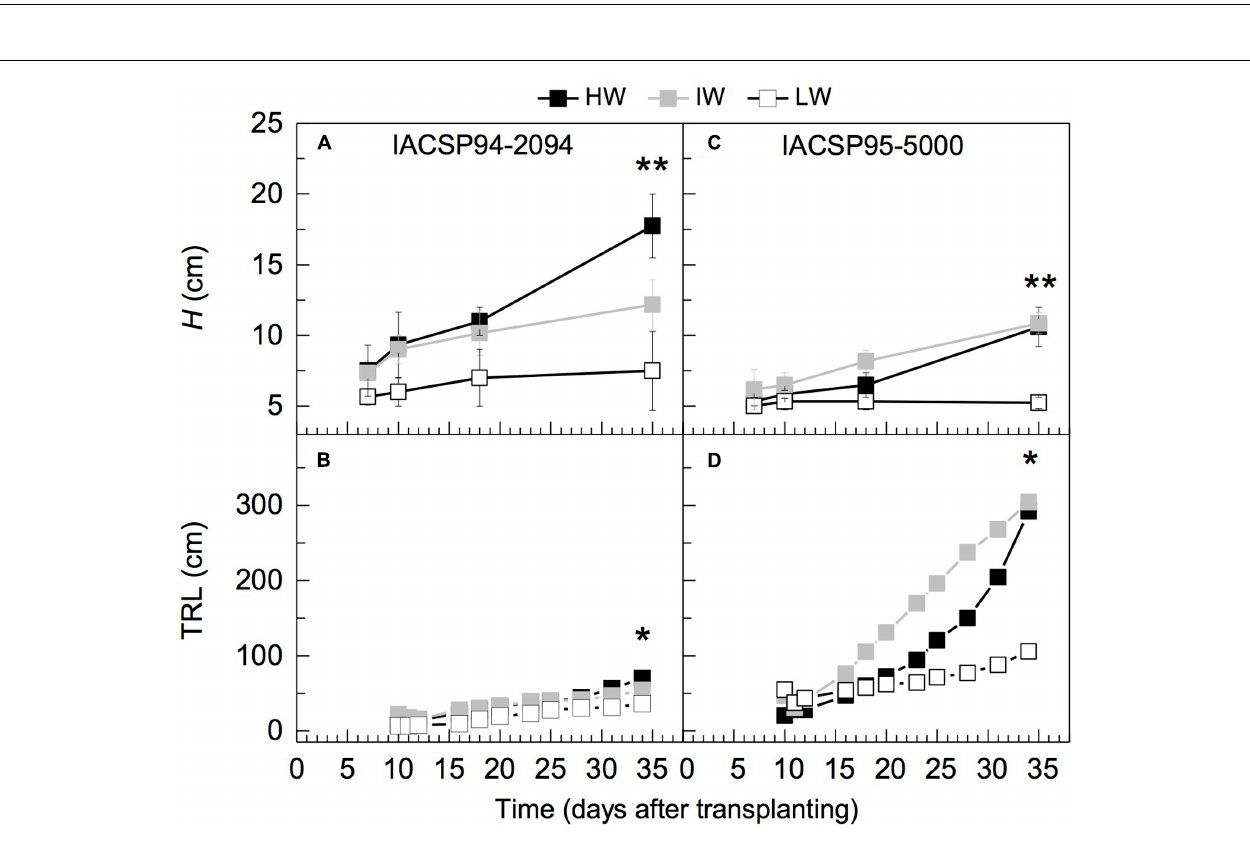
FIGURE 4 | Temporal variation of plant height ( H , in A,C ) and visible root length (TRL, in B,D ) on rhizotrons glass window of two sugarcane varieties IACSP94-2094 (A,B) and IACSP95-5000 (C,D) exposed to high (HW, in black), intermediate (IW, light gray) and low (LW, white) water availability. Each symbol represent means ( n = 3) ± SD. ∗ , ∗∗ mean statistical difference at p < 0.05 and p < 0.01, respectively.